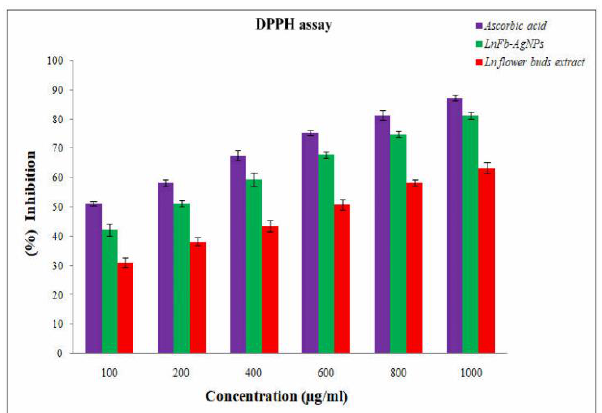
Figure 10. Graph showing antioxidant activity of biosynthesized LnFb-AgNPs from L. nepetifolia flower bud extract. flower bud